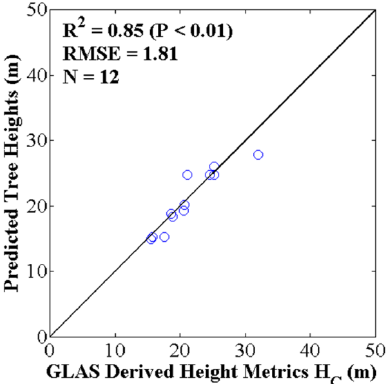
Figure 6. Comparison of the optimized ASRL model predictions with the best GLAS metric of tree height ( H in Figure 5(c)) at the FLUXNET sites (N = 12). We used a C two-fold cross validation approach that randomly divides GLAS tree heights into two equal sets of training and test